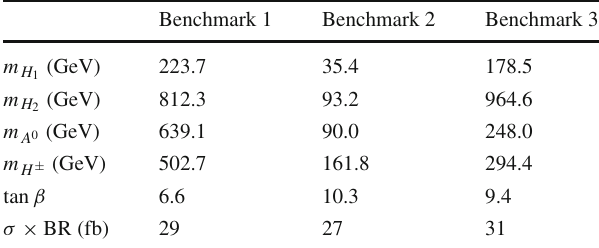
Table 4 Scalar masses and tan β values in the point with highest cross section times branching ratio for each benchmark Benchmark 1 Benchmark